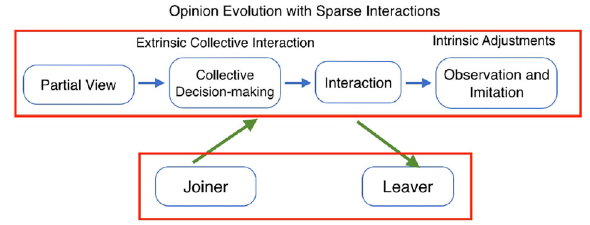
Fig. 1 The whole picture of the SCOOE model dynamics. Opinion dynamics with two components of sparse interactions (extrinsic and intrinsic forms): The focal agent with a limited view can only access a partial neighborhood. It aggregates a joint opinion of the incomplete neighborhoodbycollectivedecision-making.Then,thefocalagentonly takes this joint opinion from the extrinsic incomplete neighborhood into account by the interaction with the joint opinion, rather than by dense interactions with all neighbors or certain neighbors with similar opinions selected by polling the neighborhood. Imitation is also intro- duced to drive opinion intrinsic adjustments based on observation of the incomplete neighborhood environment without direct interactions with neighbors. The coevolution of open-ended structure and opinion: The opinion dynamics affect the leaver exiting society and associated struc- tural dynamics. A joiner with a random opinion joins. It changes the structural features and the neighborhood settings, and the neighborhood settings in turn affect the opinion